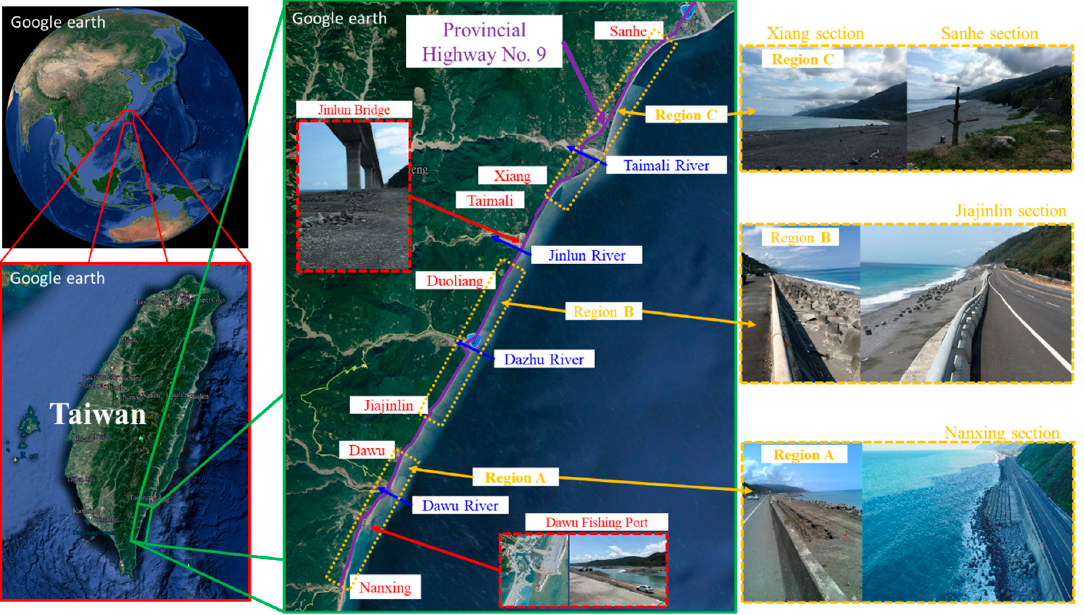
Figure 1. Location of Taitung Provincial Highway No. 9 in eastern Taiwan.